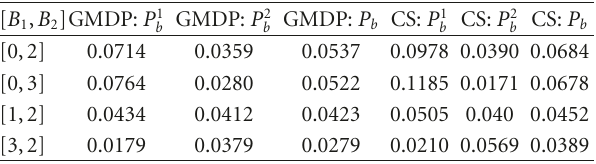
Table 7: Comparison between CS-based and GMDP-based AC policies, in which L 1 = L 2 = 2, ρ ability constraint is set to [0 . 1,0 . 05], and the connection delay con- straint is [2 . 25,0 . 5360].